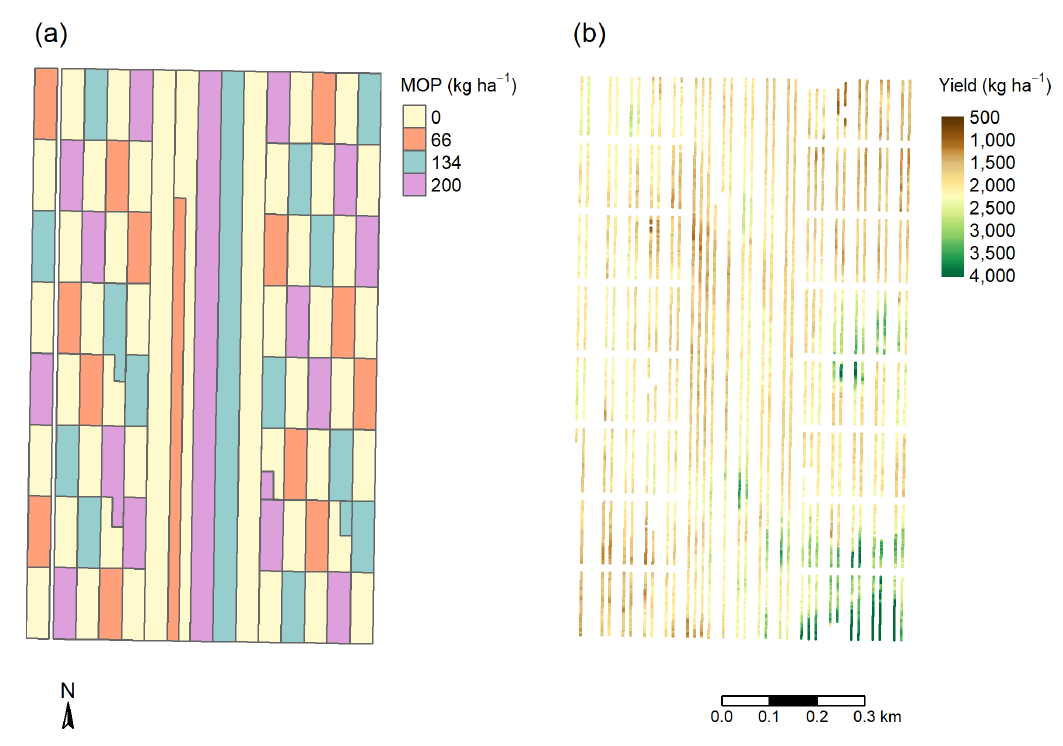
− 1 ) and ( b ) cleaned yield data (kg ha − 1